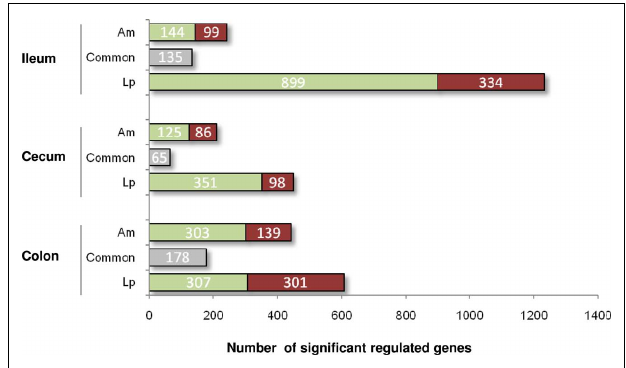
FIGURE 3 | Number of significantly up- (red) and down- (green) regulated genes in the ileum, cecum, and colon of mice mono-associated with A. muciniphila and L. plantarum vs. germ-free mice. Gray represents common regulated genes.